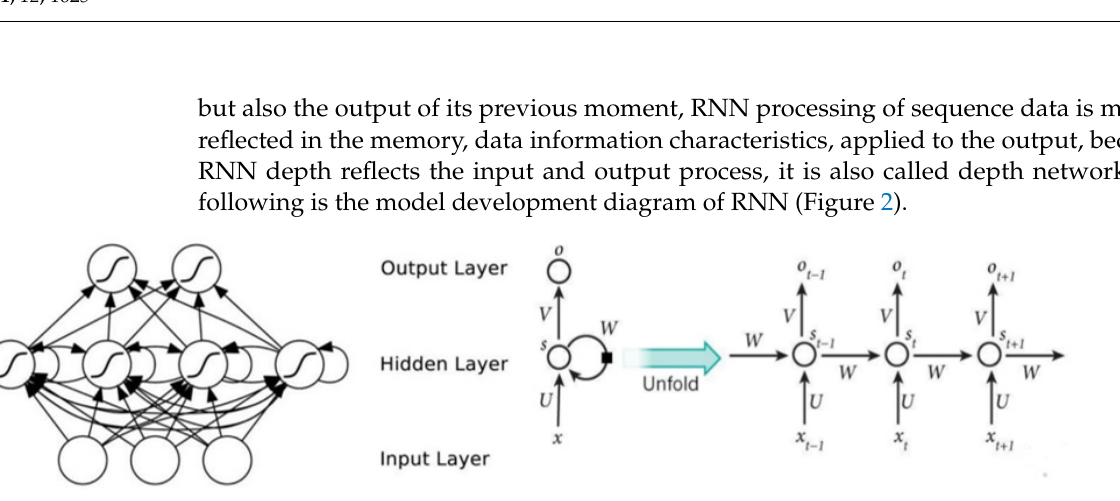
Figure 2. Model expansion diagram of recurrent neural network.